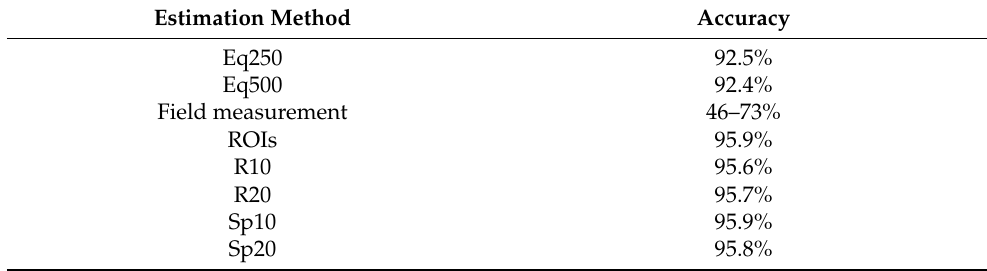
Table 2. Overall accuracy of the HS image classification. The accuracy is estimated by comparison with field measurements, random samples generated from ROIs, and other groups of random samples (Eq250, Eq500, R10, R20, Sp10, Sp20). Eq250 and Eq500 are the equalized samples groups using 250 and 500 pixels respectively for each class as reference; R10 and R20 are the random samples groups using 10% and 20 % of total pixels as reference respectively; Sp10 and Sp20 are the stratified- proportionate samples groups using 10% and 20 % of total pixels as reference, respectively.